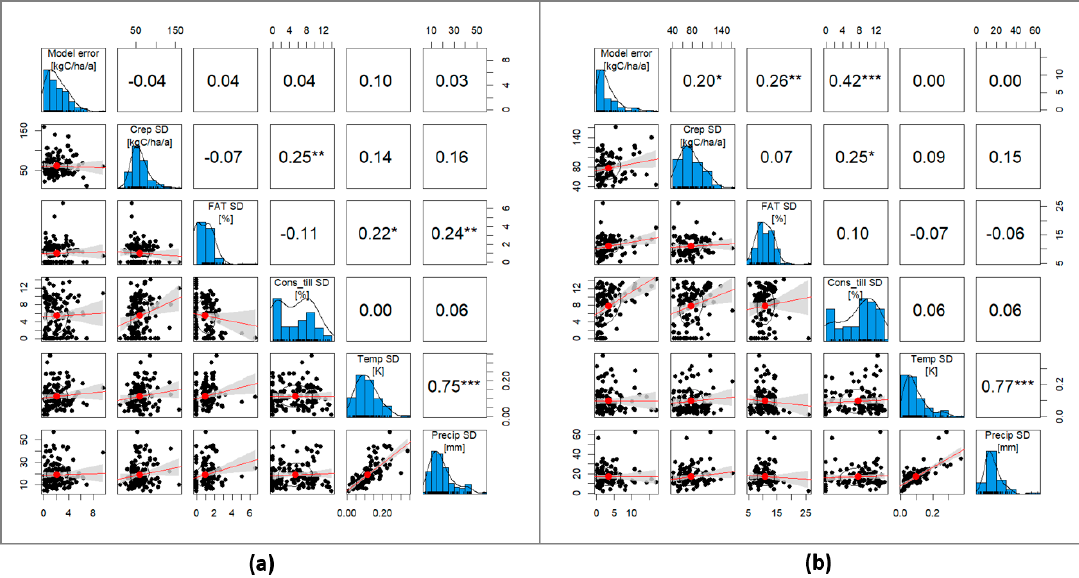
Figure 5. Correlation matrices between the absolute errors of the LAU-level model set-up and the spatial dispersion (standard deviation) of a set of predictor variables. ( a ) Correlation matrix for a subset of LAU regions that show a low variability in carbon turnover conditions (BAT); ( b ) correlation matrix for a subset of LAU regions that show a high variability in carbon turnover conditions (BAT). The predictors of the matrices are the soil carbon reproduction flux (C rep ), soil fine particle content (FAT), conservation tillage shares (Cons_till), annual mean temperature (Temp) and annual precipitation (Precip). For each predictor, its regional dispersion (standard deviation—SD) within an administrative unit was calculated from the reference dataset and used for the correlation matrices. The distribution of each variable is shown on the diagonal. Below this diagonal, the bivariate scatter plots with a fitted line are displayed. Above the diagonal, the value of the correlation is shown as well as its significance level (stars), where the p -values of <0.001, <0.01, <0.05 are associated with the symbols ***, ** and *,